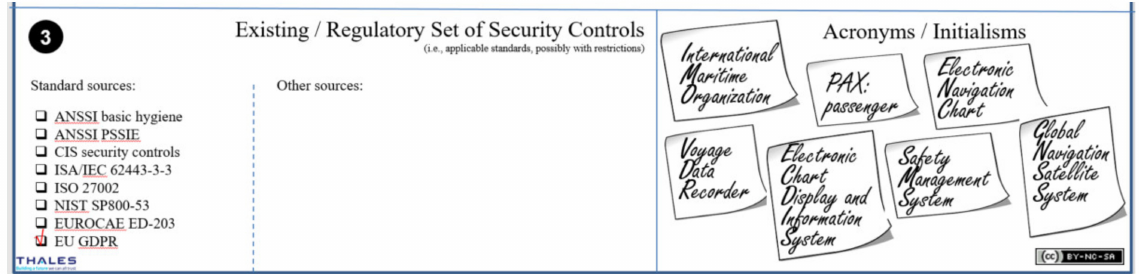
Figure 4. Naval use case—security regulations, policies, security standards and abbreviations. The left part is dedicated to applicable regulations, policies and security